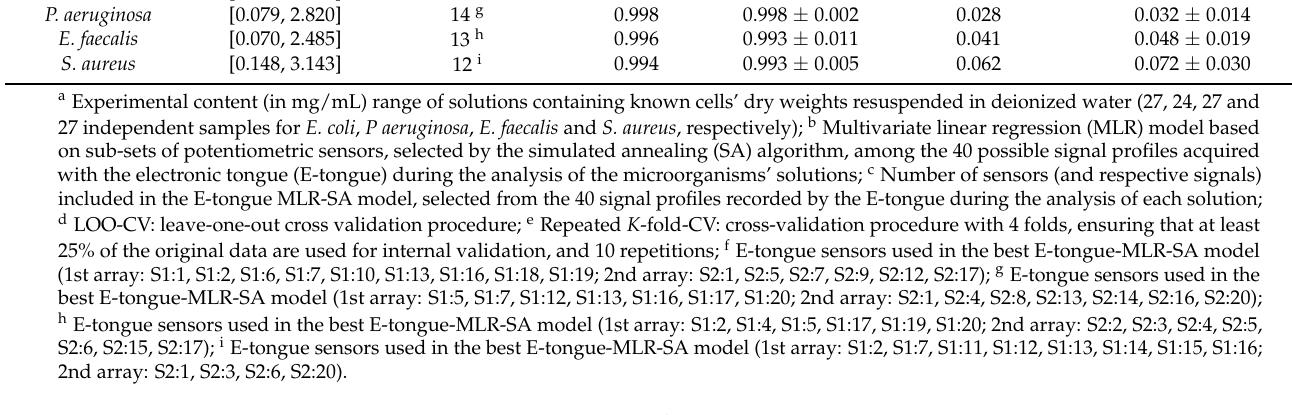
Table 2. Predictive performance of E-tongue-MLR-SA models regarding the quantification of typical water-food contamina- tion microorganisms (contents determined according to cells’ dry weight) resuspended in aqueous solutions. E-Tongue-MLR-SA Models b Concentration Determination Coefficient ( R 2 ) Root-Mean-Square Error (RMSE, mg/mL) Microorganism Range (mg/mL) a N ◦ of Sensors c Repeated LOO-CV d LOO-CV d Repeated K -Fold-CV e K-Fold-CV e E. coli [0.083, 3.203] 15 f 0.996 0.993 ± 0.008 0.054 0.076 ± 0.036 P. aeruginosa [0.079, 2.820] 14 g 0.998 0.998 ± 0.002 0.028 0.032 ± 0.014 E. faecalis [0.070, 2.485] 13 h 0.996 0.993 ± 0.011 0.041 0.048 ± 0.019 S. aureus [0.148, 3.143] 12 i 0.994 0.993 ± 0.005 0.062 0.072 ±